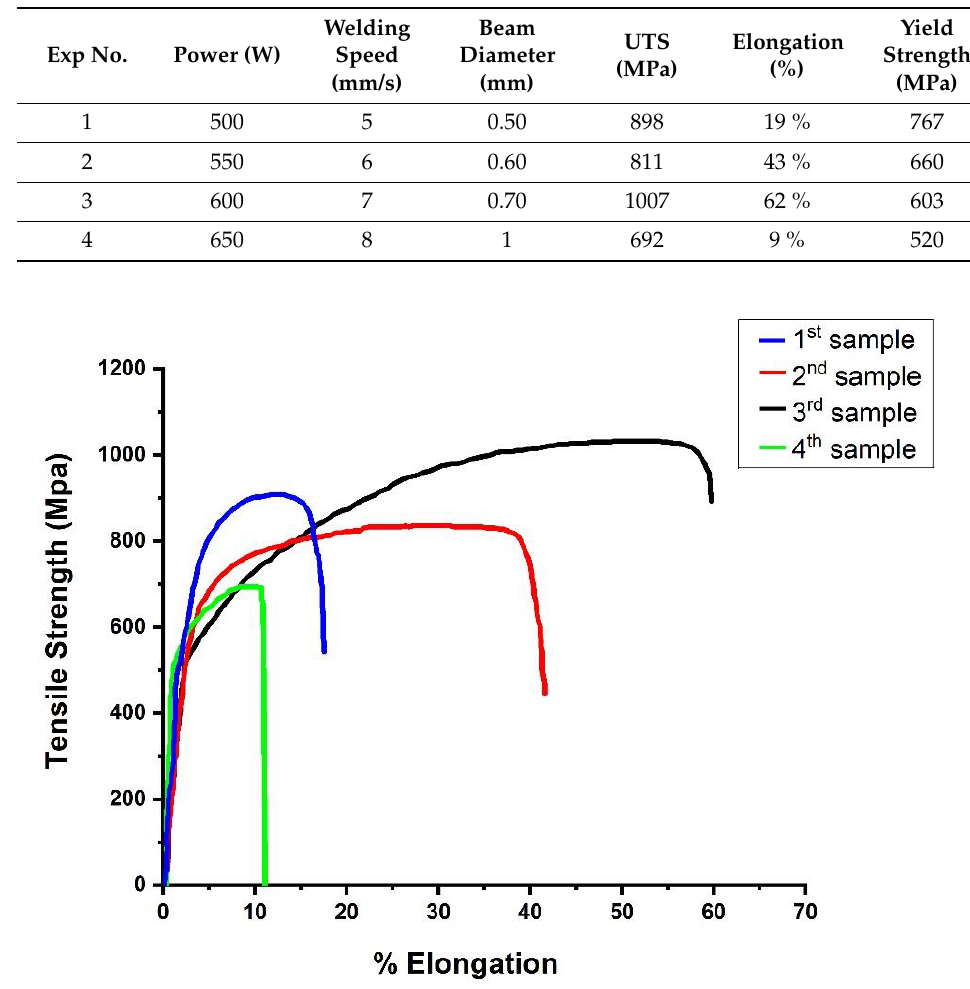
Figure 3. Stress–strain curve for welded samples. Table 3. Experimental values of mechanical properties for the welded samples with different pro- cess parameters.